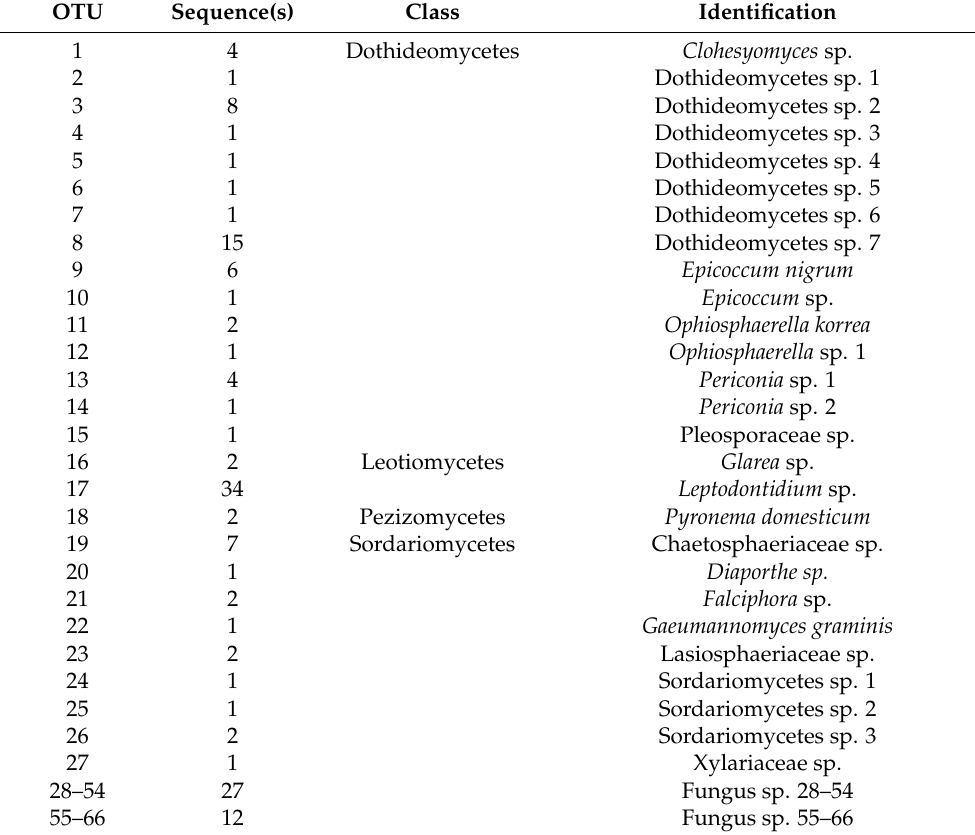
Table 3. Taxonomic identification of OTUs from the cultured endophytes from site III using ITS sequences. The sequences were compared using BLAST through the UNITE database. For a more detailed examination of the identification see Supplementary Table S3. 12 cultures could not be identified because no DNA was extracted and for 27 cultures no ITS sequence was amplified so these cultures were categorised as individual OTUs. Names of organisms are given according to Species Fungorum (http://www.indexfungorum.org/; accessed on 8 March 2018 to 3 July